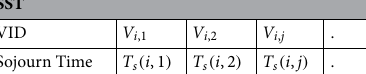
Table 3. Range of the sojourn time.